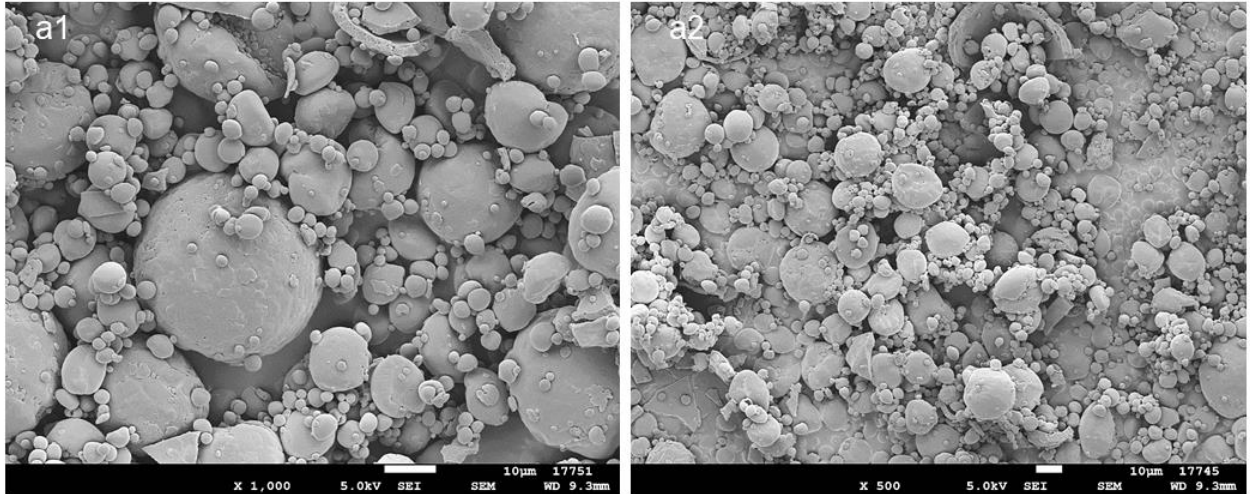
Figure 1. SEM images of the PLGA MPs loaded with 17.4% ATV: ( a1 ) ×1000, ( a2 ) ×500. Scale bar: 10 μm.